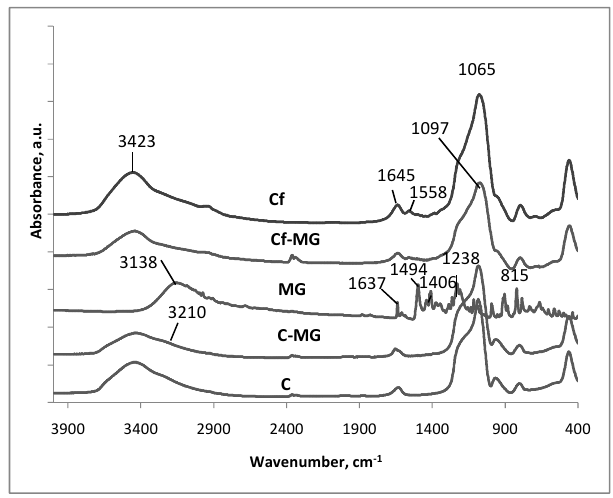
Figure 3. Comparative representation of Fourier Transform Infrared Spectroscopy (FTIR) spectra recorded.